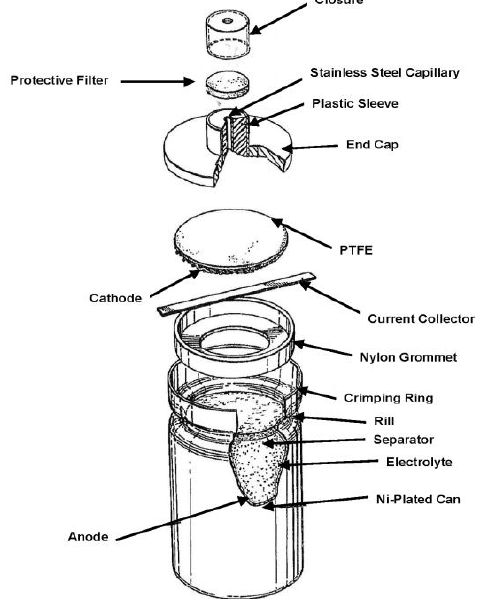
Figure 1. Early version of lead-based electrochemical sensor (modified from